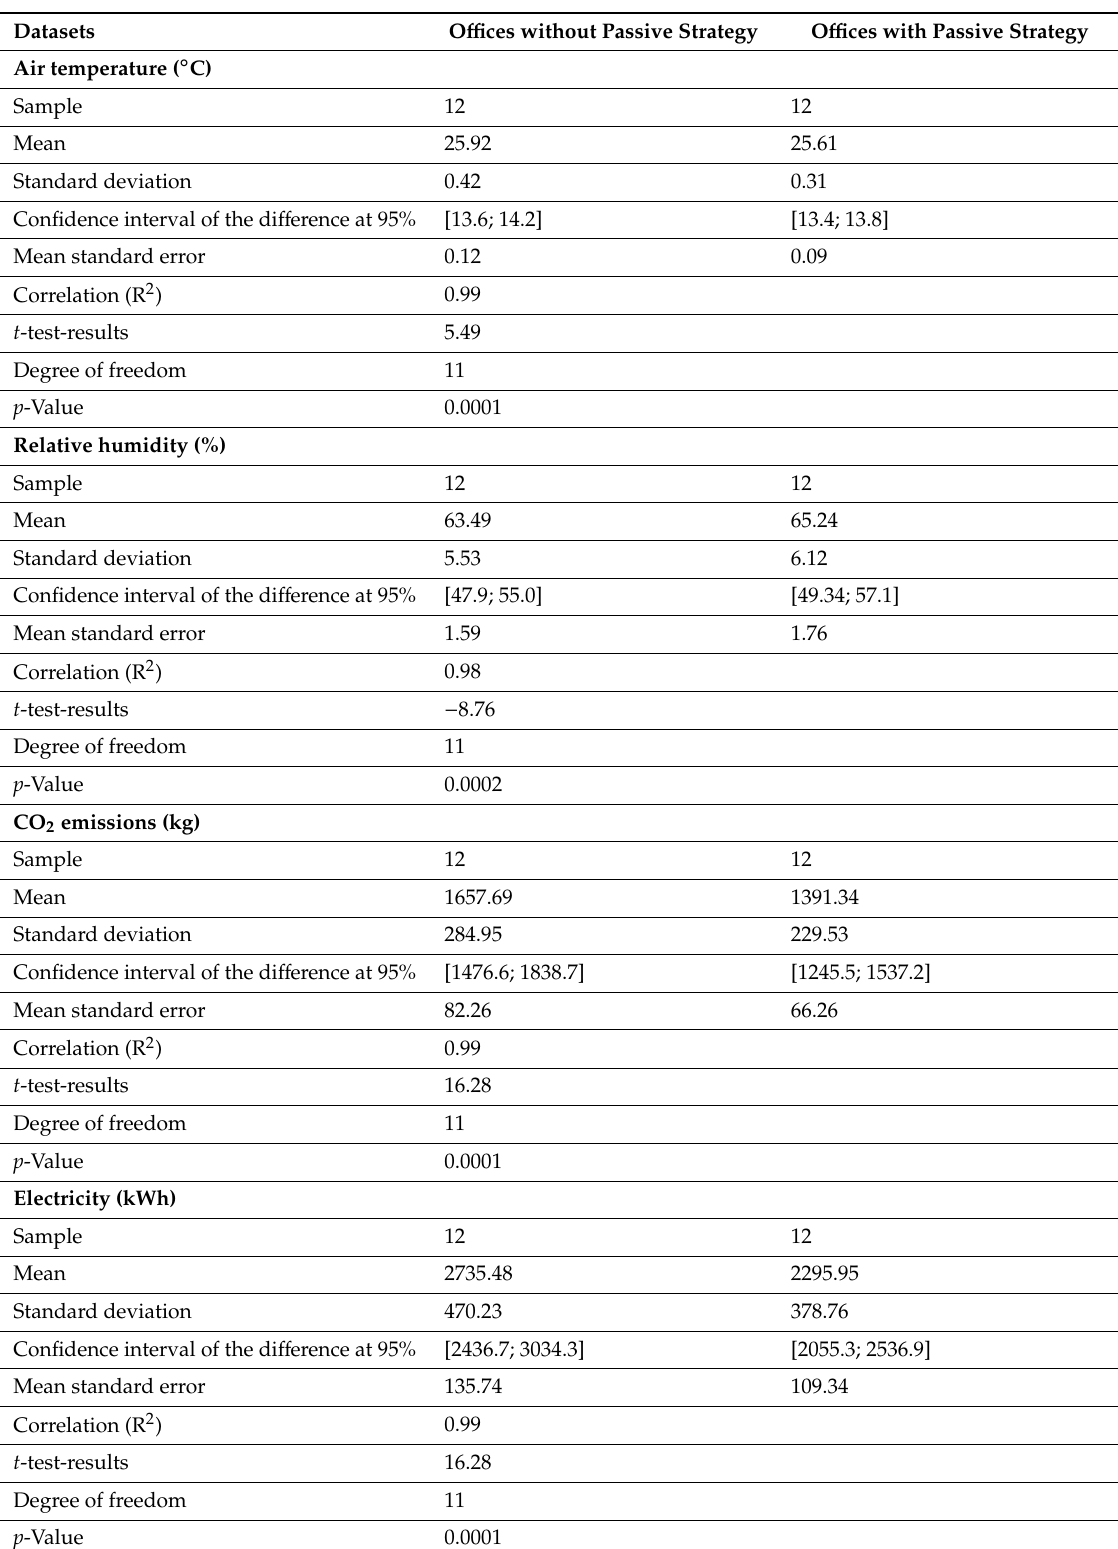
Table 7. Statistical analysis of di ff erent